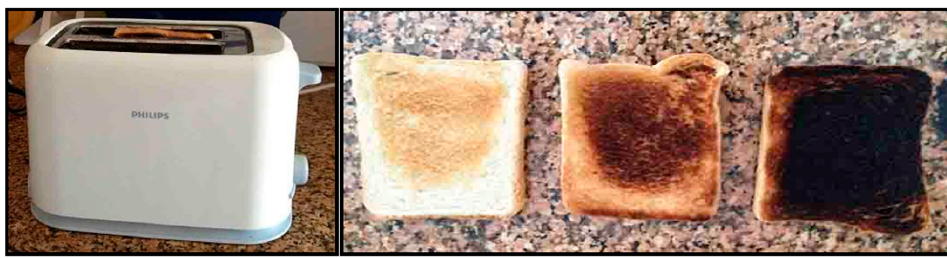
Figure 4. Levels of loaf bread toasting studied ( right : slightly, medium, and heavily toasted) using a Philips toaster ( left ).